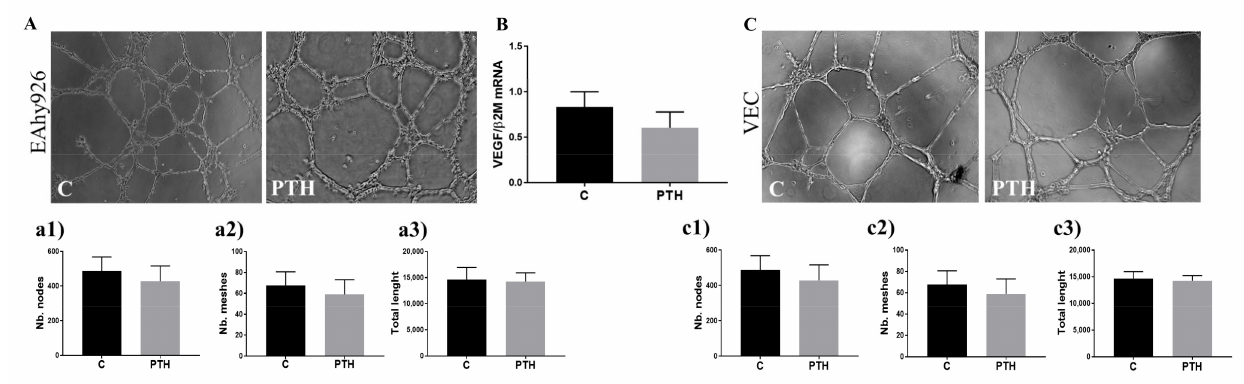
Figure 7. Effect of conditioned media released by control and PTH-exposed VEC on endothelial cells tube formation. ( A ). Tube-like formation by umbilical endothelial cells (EAhy926) induced by CM